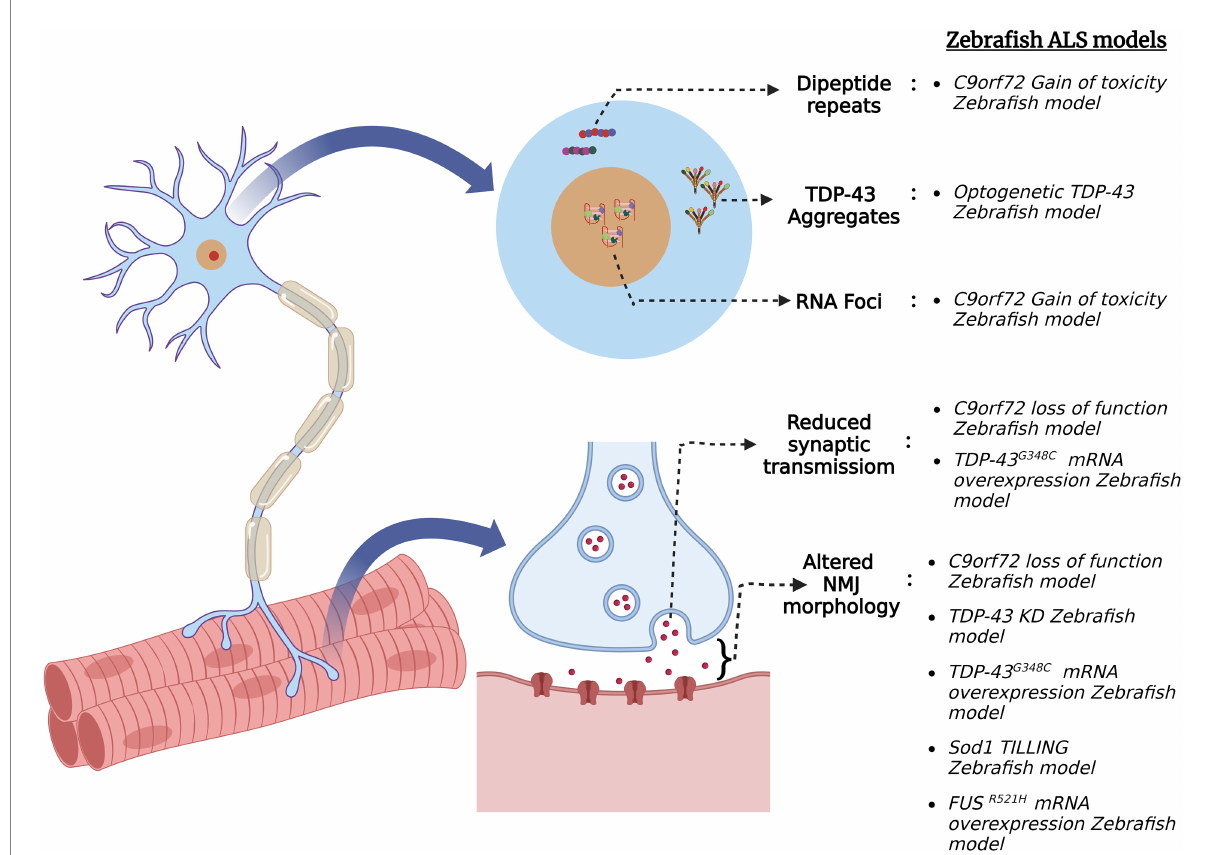
FIGURE 3 Schematic summary of various pathological signatures of ALS that are replicated in zebrafish ALS models. Zebrafish models were generated via several genetic approaches for the four major ALS genes (C9orf72, FUS , TARDBP (TDP-43) and SOD1 ) and they exhibit ALS hallmarks such as formation of toxic dipeptide repeats, TDP-43 aggregation, RNA foci formation, altered neuromuscular junction (NMJ) morphology and reduced synaptic transmission at